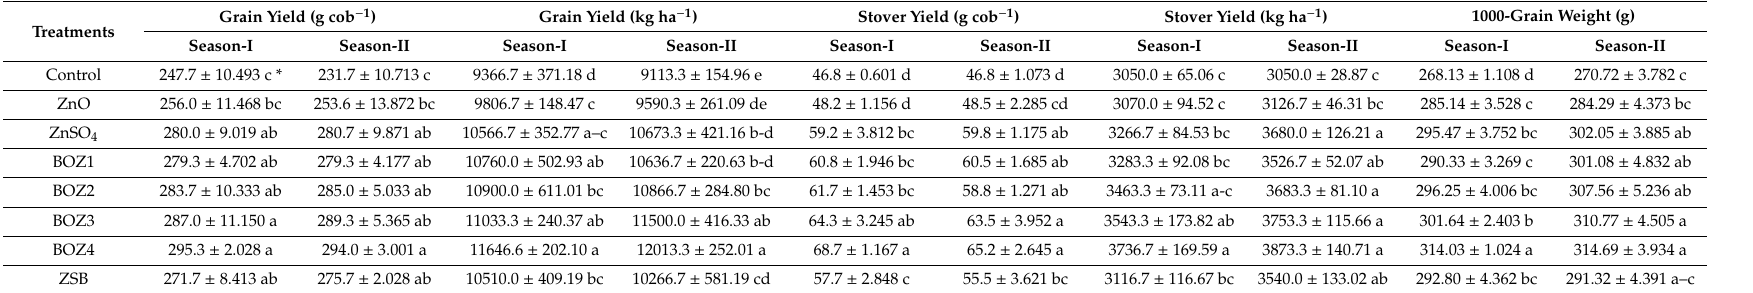
Table 3. E ff ect of di ff erent Zn sources on the yield of maize grown in two di ff erent cropping